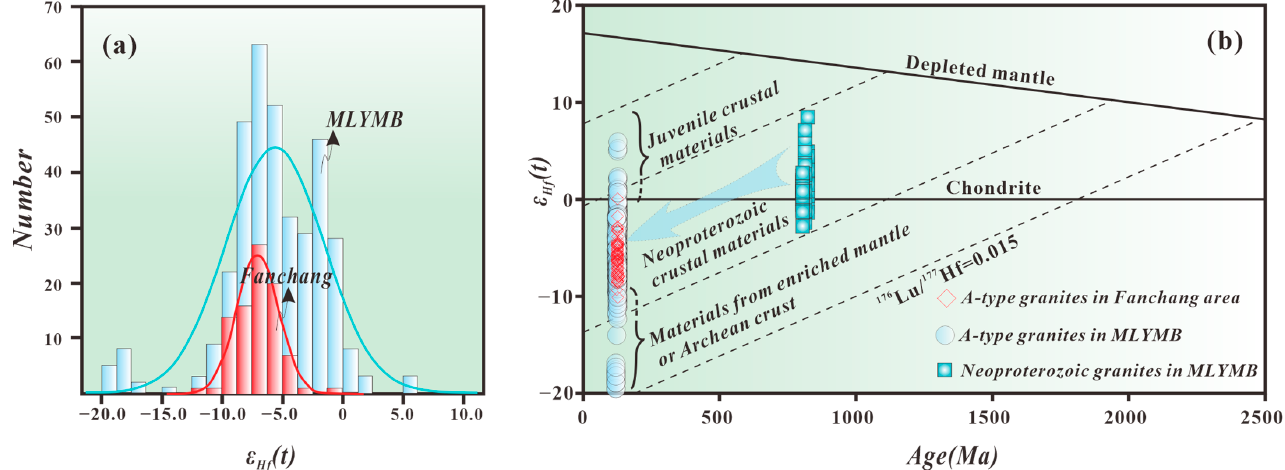
Figure 9. Diagram of initial ε Hf (t) vs. age of A-type granites in the MLYMB: ( a ) Histograms of ε Hf (t); ( b ) Diagram of ε Hf (t) vs. age. Data sources (see Supplement Table S4): A-type granites of the FVB [85,88]; A-type granites of the MLYMB